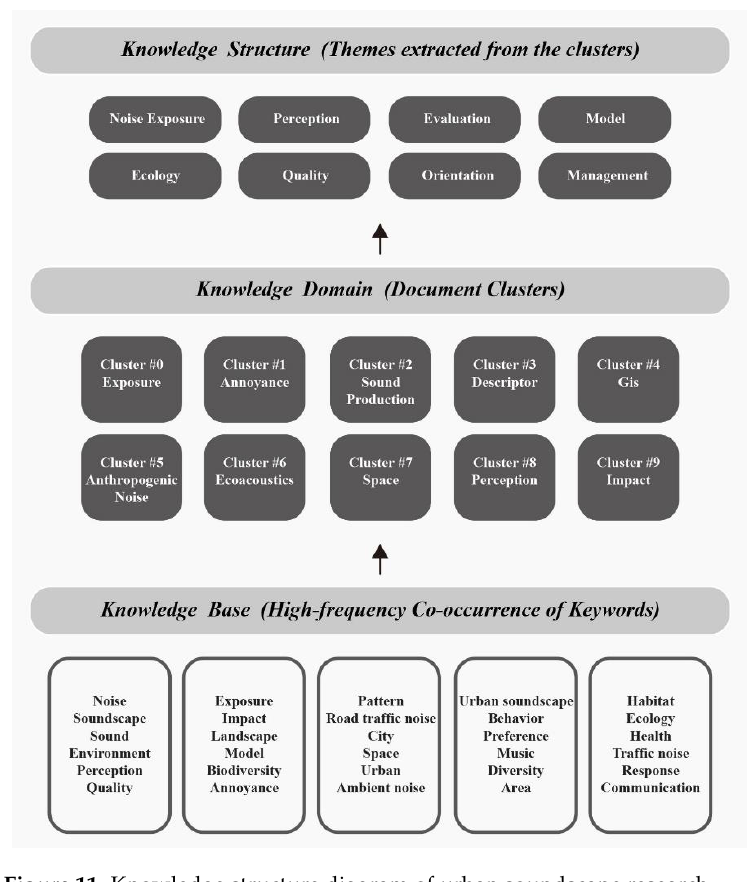
Figure 11. Knowledge structure diagram of urban soundscape research.